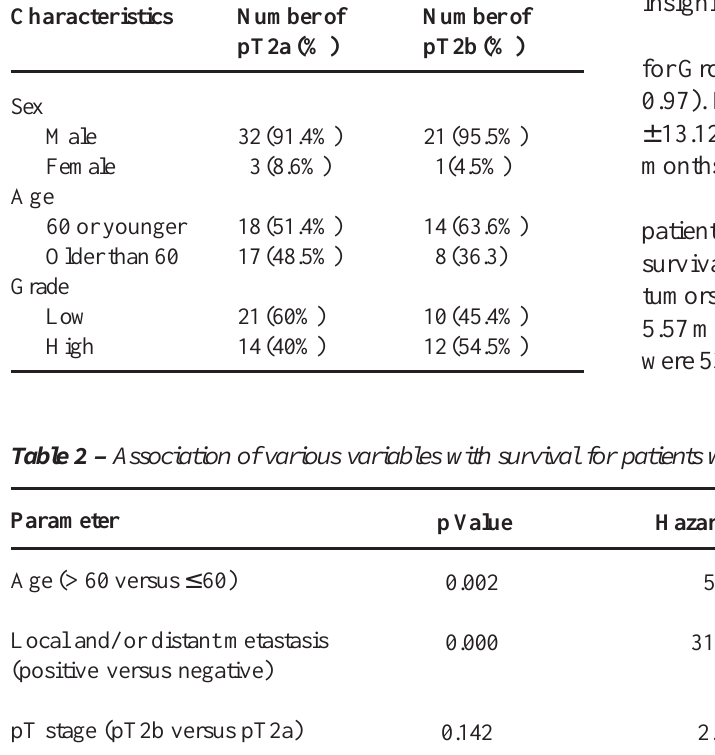
Table 1 – Distribution of cases by sex, age and grade. Characteristics